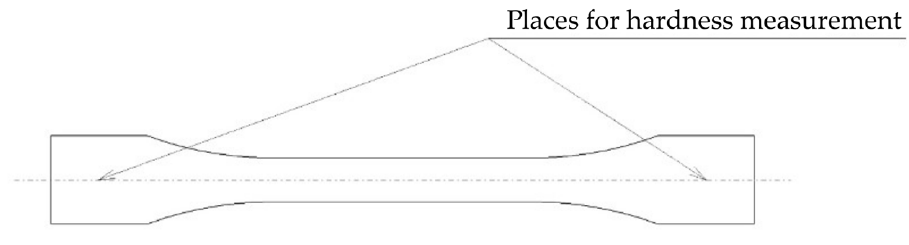
Figure 2. Places for hardness measurement.